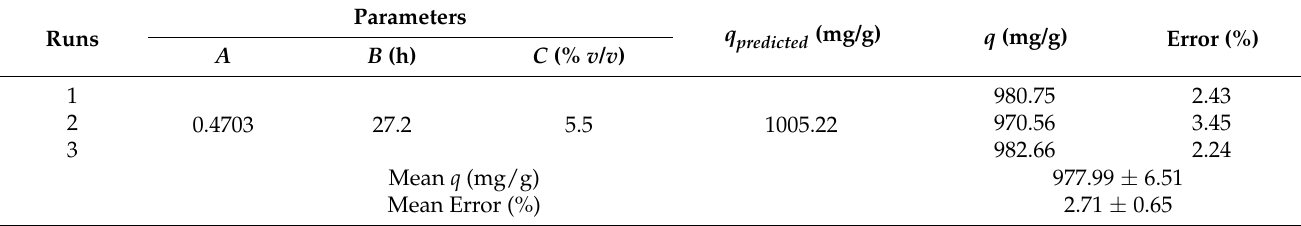
Table 3. Validation of optimization result.